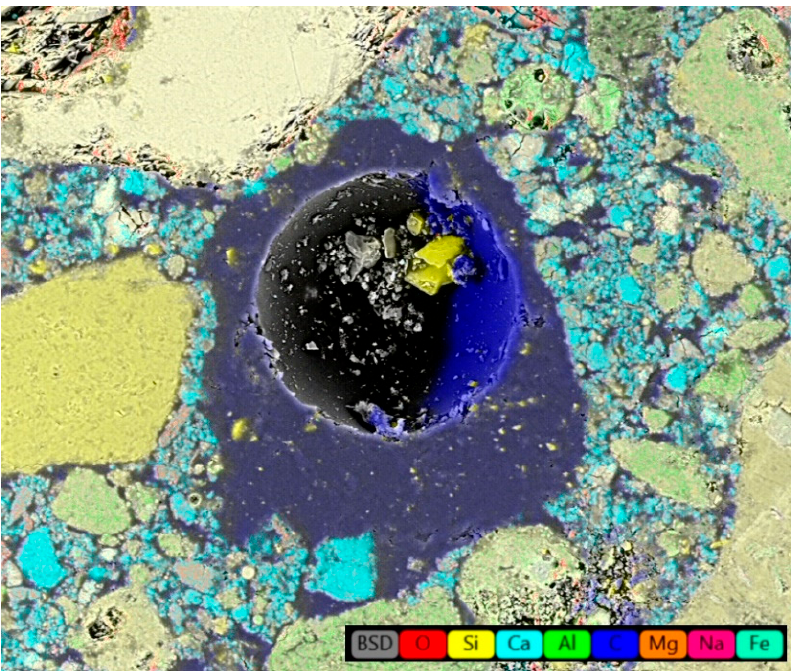
Figure 3. Element distribution map of hardened C1.5 mixture.